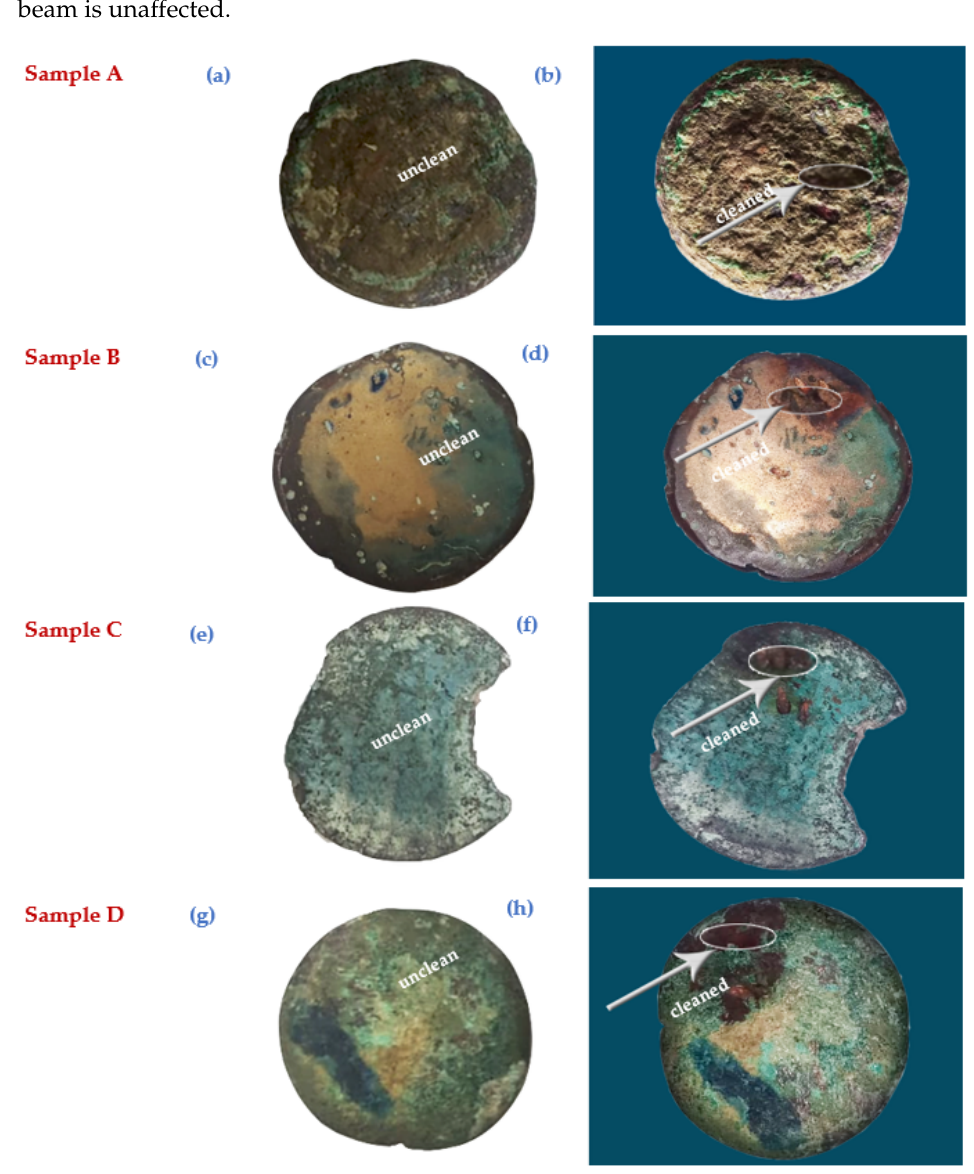
Figure 4. Process of laser cleaning of the studied corroded coins before and after cleaning via continuous shooting for 10 s ( a , b ) coin A; ( c , d ) coin B; ( e , f ) coin C; ( g , h ) coin D.